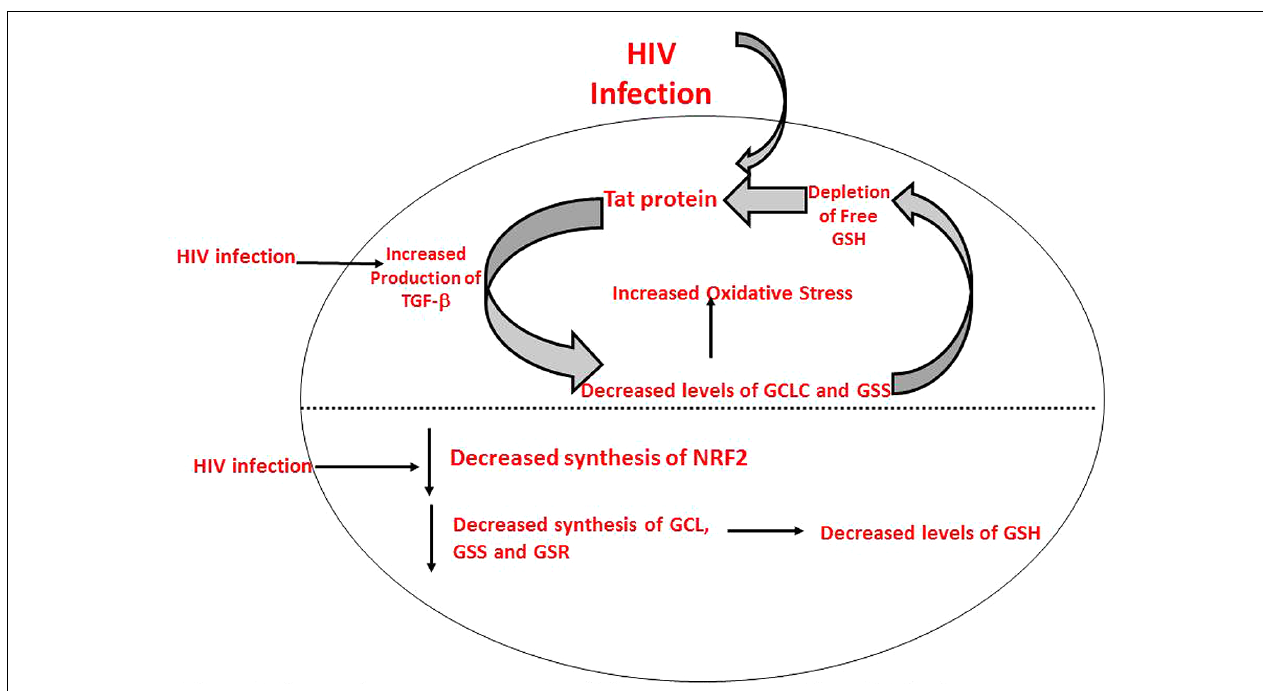
FIGURE 5 | Model illustrating causes for decreased levels of GSH in individuals with HIV